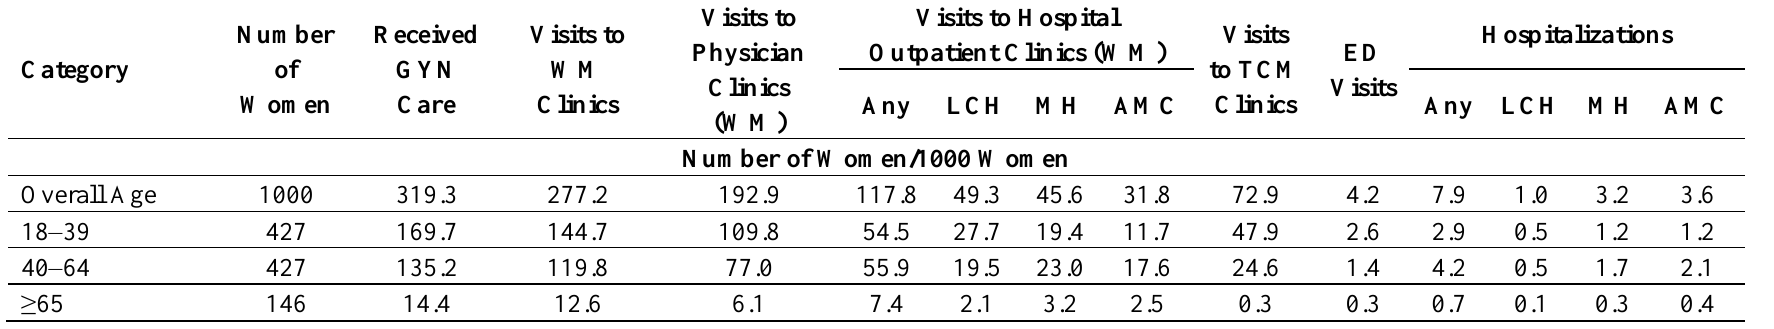
Table 1. Estimates of ecology of gynecological care in Taiwan in terms of type of care, stratified by age group.